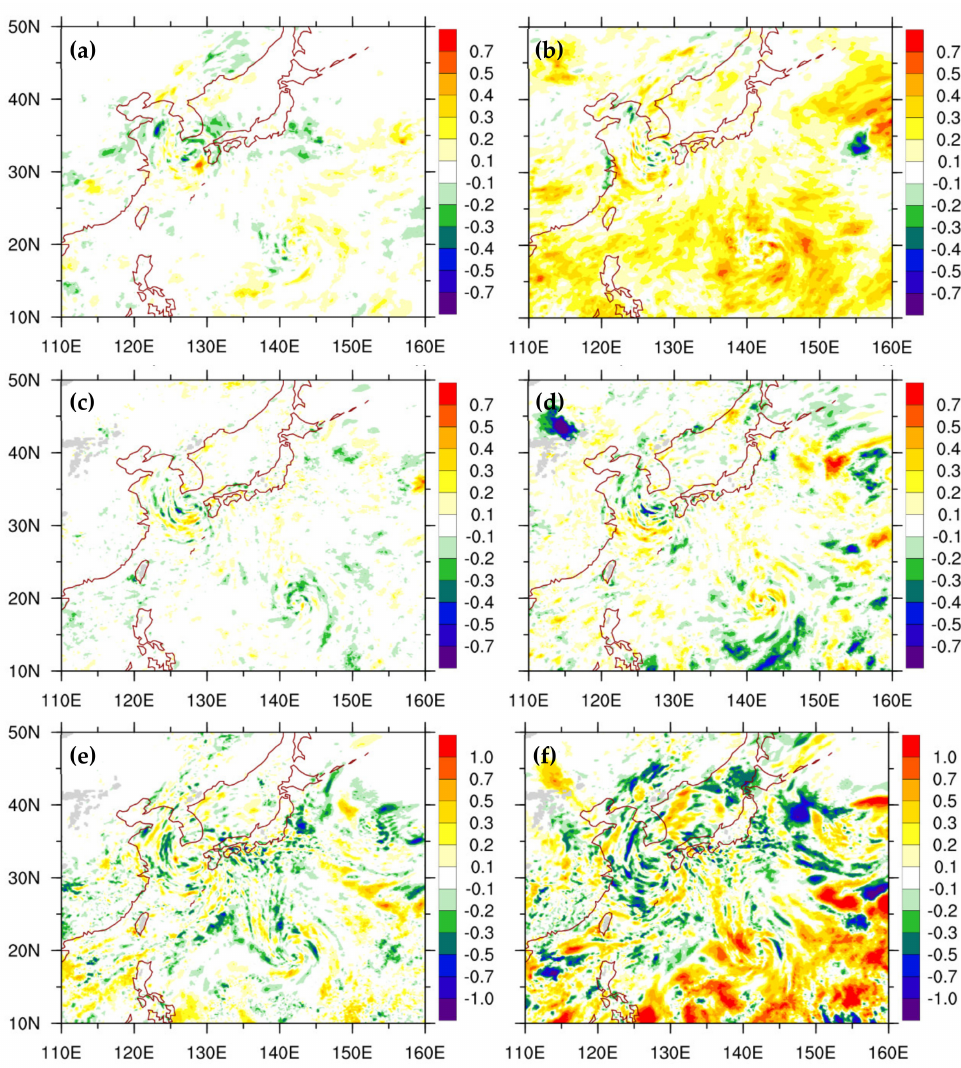
Figure 5. As in Figure 4, but for the time-averaged